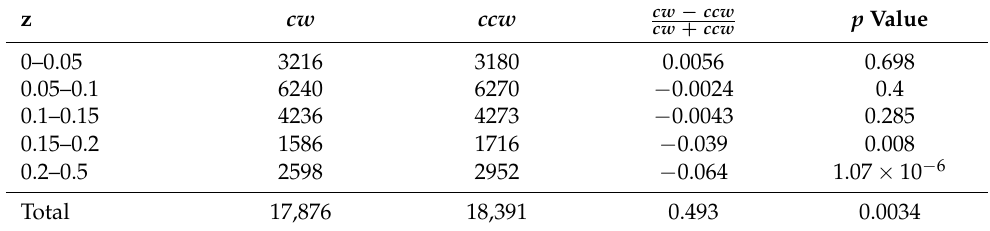
Table 9. The number of clockwise and counterclockwise galaxies in SDSS, separated into different redshift ranges. All galaxies are within the RA range of (120°, 210°). The results are taken from [162]. z cw ccw cw − ccw cw +